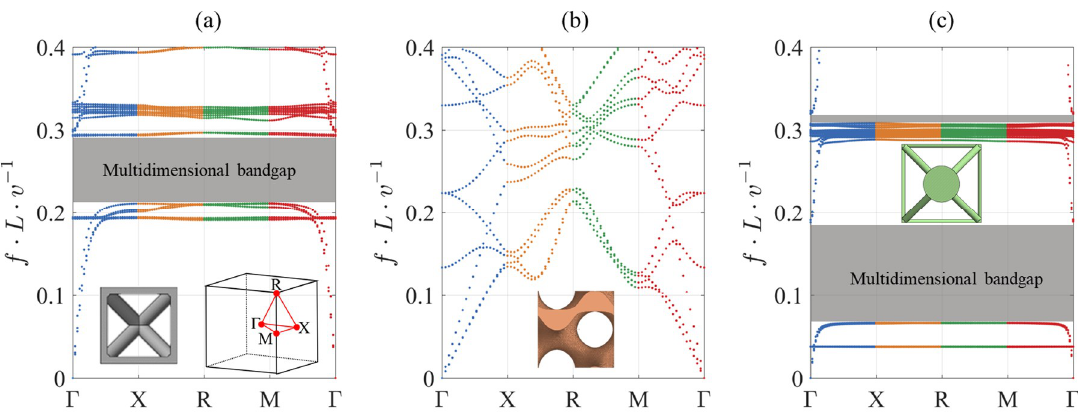
Figure 10. DCs of ( a ) BCC xyz , ( b ) gyroid TPMS, and ( c ) res-BCC xyz lattice structures with 20% volume fraction.